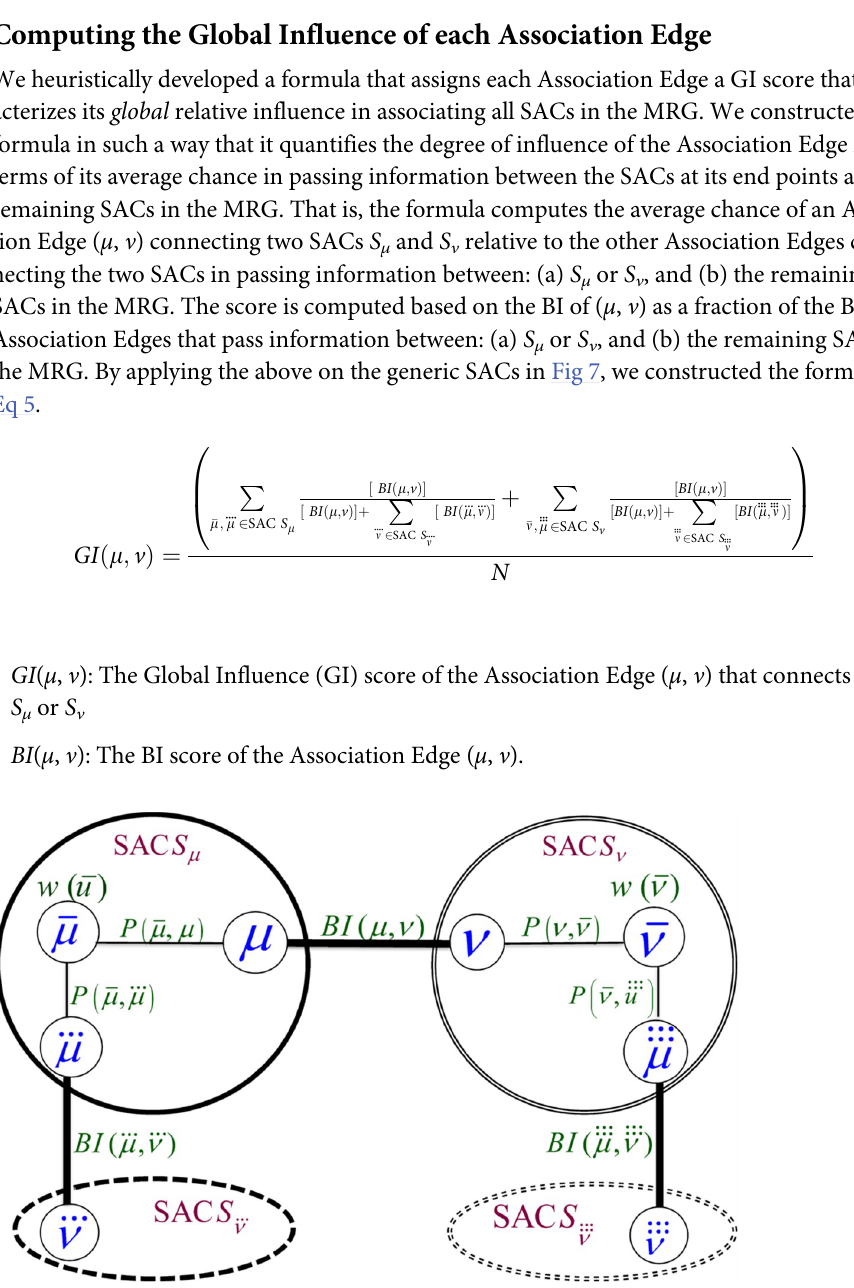
Fig 7. Generic notations used for constructing the formula in Eq 5 for computing the GI ( μ , ν ) of an Association Edge( μ , ν ).